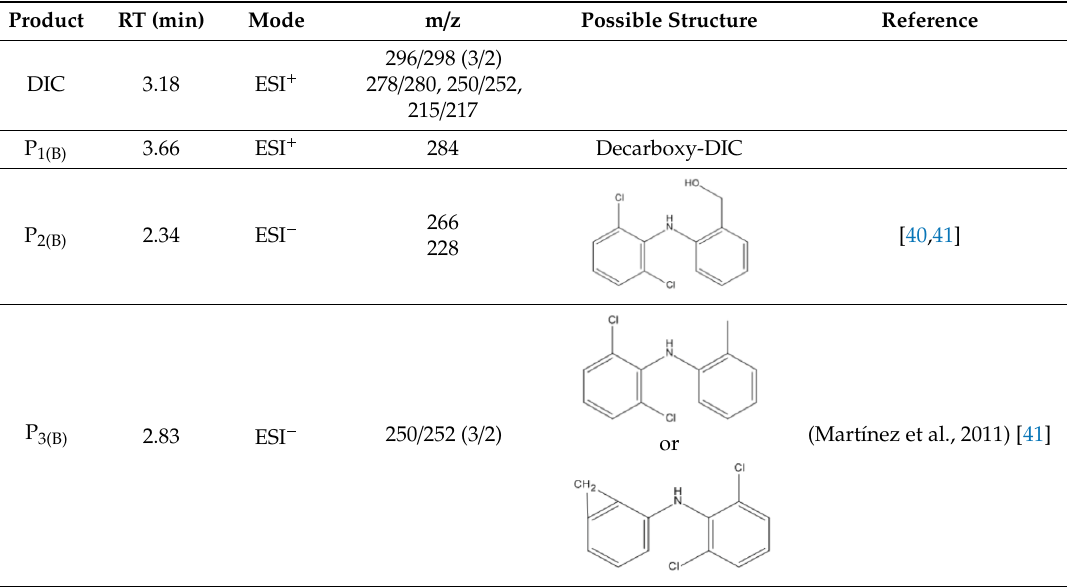
Table 2. MS data of products in the presence of CTAB.